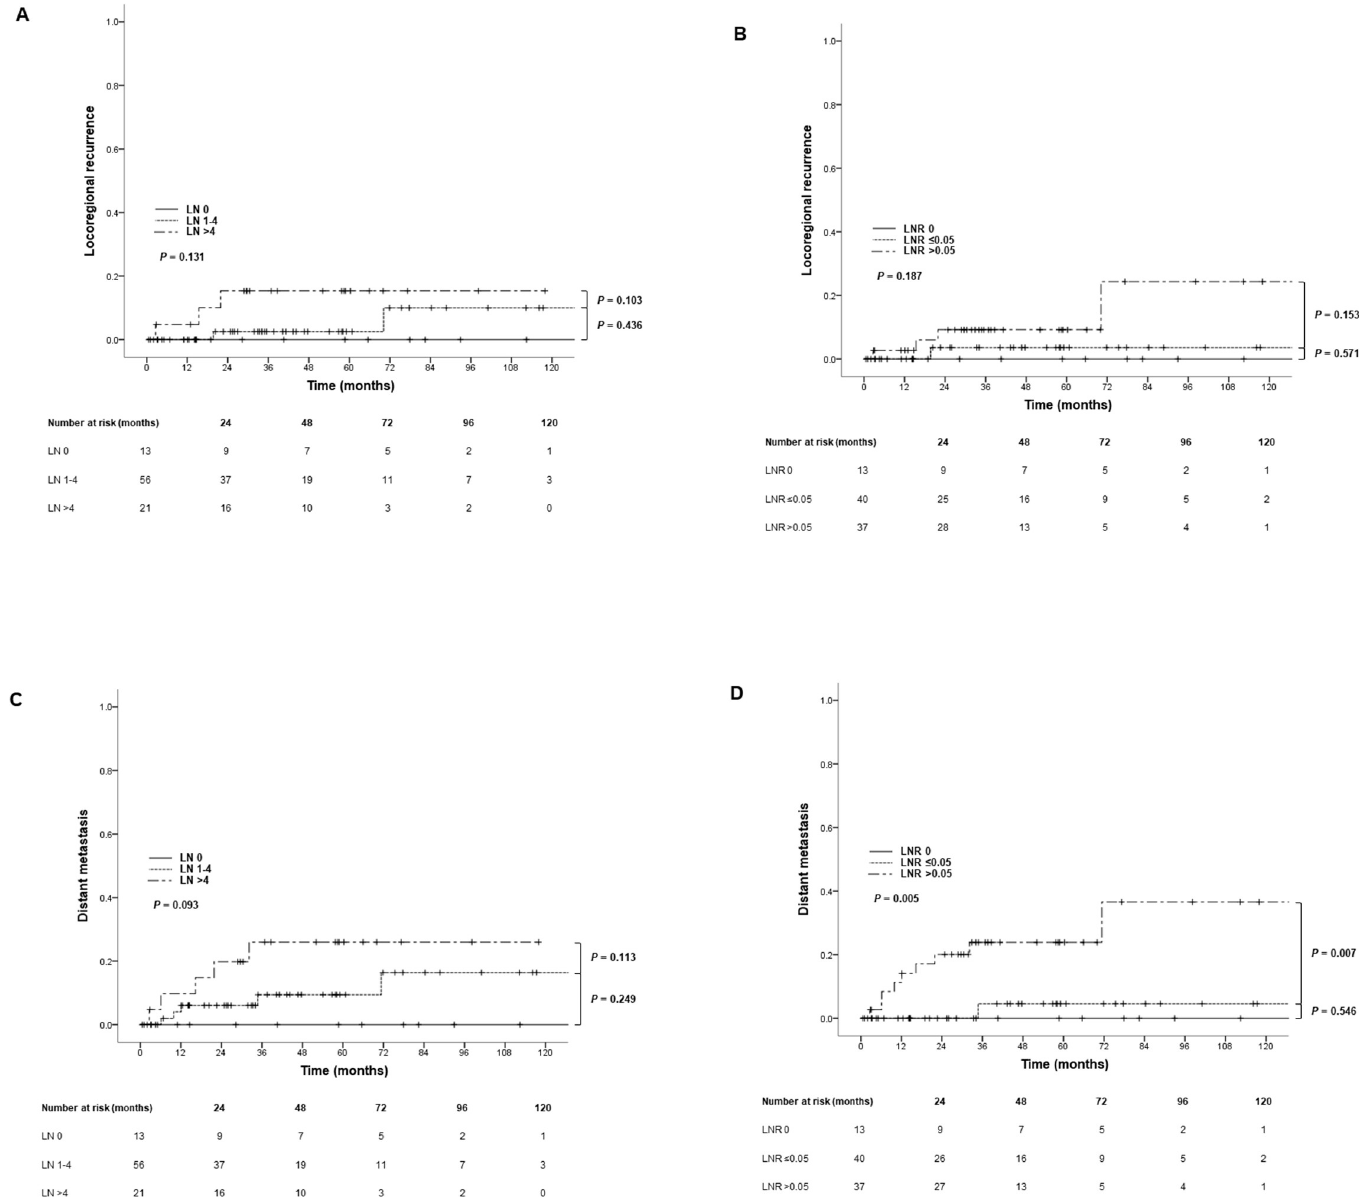
Fig 3. Kaplan-Meier curves of locoregional recurrence (LRR) (A, B) and distant metastasis (DM) (C, D) according to lymph node numbers and